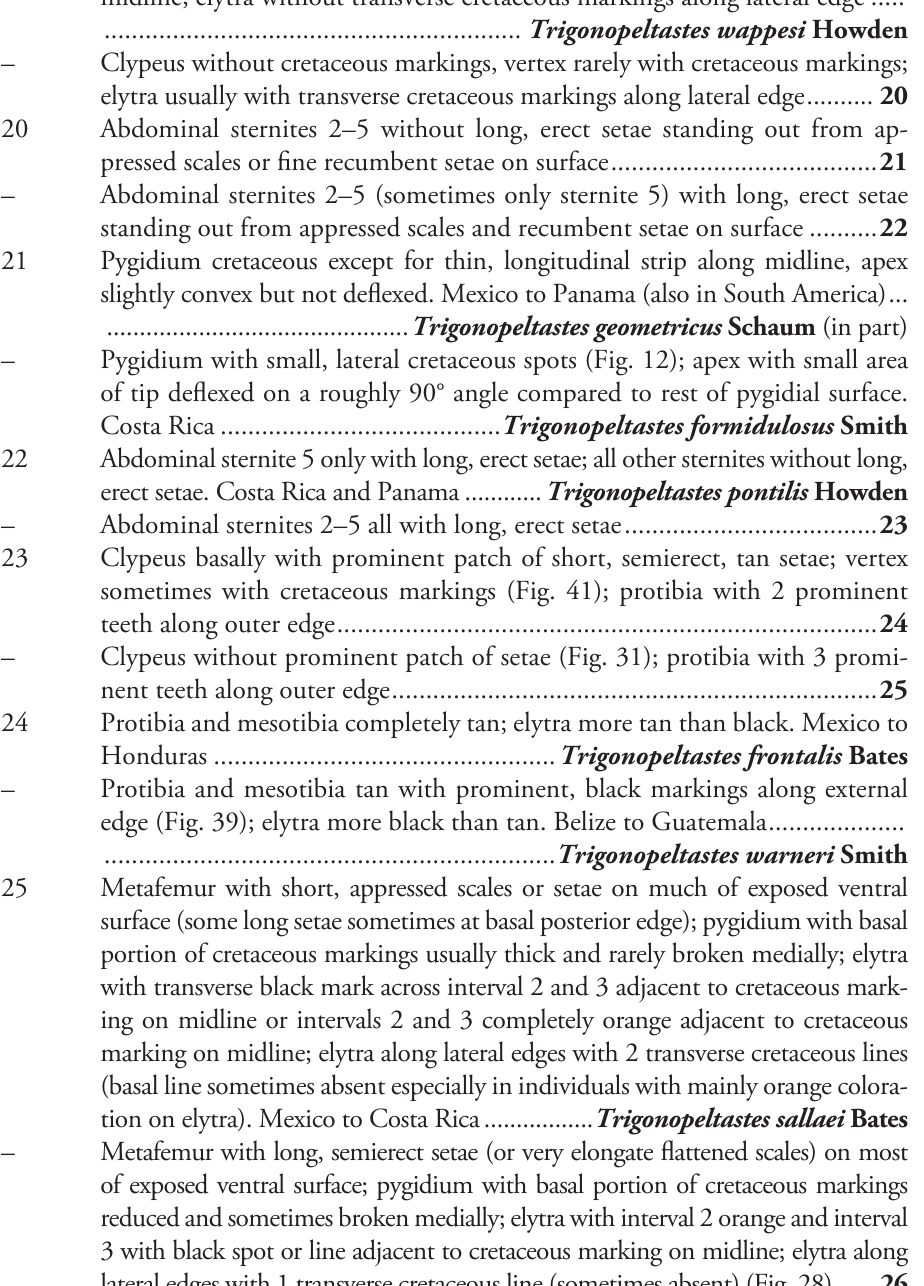
Clypeus and vertex each with wide cretaceous markings on either side of midline; elytra without transverse cretaceous markings along lateral edge ..... ............................................................. Trigonopeltastes wappesi Howden – Clypeus without cretaceous markings, vertex rarely with cretaceous markings; elytra usually with transverse cretaceous markings along lateral edge .......... 20 20 Abdominal sternites 2–5 without long, erect setae standing out from ap- pressed scales or fine recumbent setae on surface ....................................... 21 – Abdominal sternites 2–5 (sometimes only sternite 5) with long, erect setae standing out from appressed scales and recumbent setae on surface .......... 22 21 Pygidium cretaceous except for thin, longitudinal strip along midline, apex slightly convex but not deflexed. Mexico to Panama (also in South America) ... .............................................. Trigonopeltastes geometricus Schaum (in part) – Pygidium with small, lateral cretaceous spots (Fig. 12); apex with small area of tip deflexed on a roughly 90° angle compared to rest of pygidial surface. Costa Rica ......................................... Trigonopeltastes formidulosus Smith 22 Abdominal sternite 5 only with long, erect setae; all other sternites without long, erect setae. Costa Rica and Panama ............ Trigonopeltastes pontilis Howden – Abdominal sternites 2–5 all with long, erect setae ..................................... 23 23 Clypeus basally with prominent patch of short, semierect, tan setae; vertex sometimes with cretaceous markings (Fig. 41); protibia with 2 prominent teeth along outer edge ............................................................................... 24 – Clypeus without prominent patch of setae (Fig. 31); protibia with 3 promi- nent teeth along outer edge ....................................................................... 25 24 Protibia and mesotibia completely tan; elytra more tan than black. Mexico to Honduras .................................................. Trigonopeltastes frontalis Bates – Protibia and mesotibia tan with prominent, black markings along external edge (Fig. 39); elytra more black than tan. Belize to Guatemala .................... .................................................................. Trigonopeltastes warneri Smith 25 Metafemur with short, appressed scales or setae on much of exposed ventral surface (some long setae sometimes at basal posterior edge); pygidium with basal portion of cretaceous markings usually thick and rarely broken medially; elytra with transverse black mark across interval 2 and 3 adjacent to cretaceous mark- ing on midline or intervals 2 and 3 completely orange adjacent to cretaceous marking on midline; elytra along lateral edges with 2 transverse cretaceous lines (basal line sometimes absent especially in individuals with mainly orange colora- tion on elytra). Mexico to Costa Rica ................. Trigonopeltastes sallaei Bates – Metafemur with long, semierect setae (or very elongate flattened scales) on most of exposed ventral surface; pygidium with basal portion of cretaceous markings reduced and sometimes broken medially; elytra with interval 2 orange and interval 3 with black spot or line adjacent to cretaceous marking on midline; elytra along lateral edges with 1 transverse cretaceous line (sometimes absent) (Fig. 28) .......